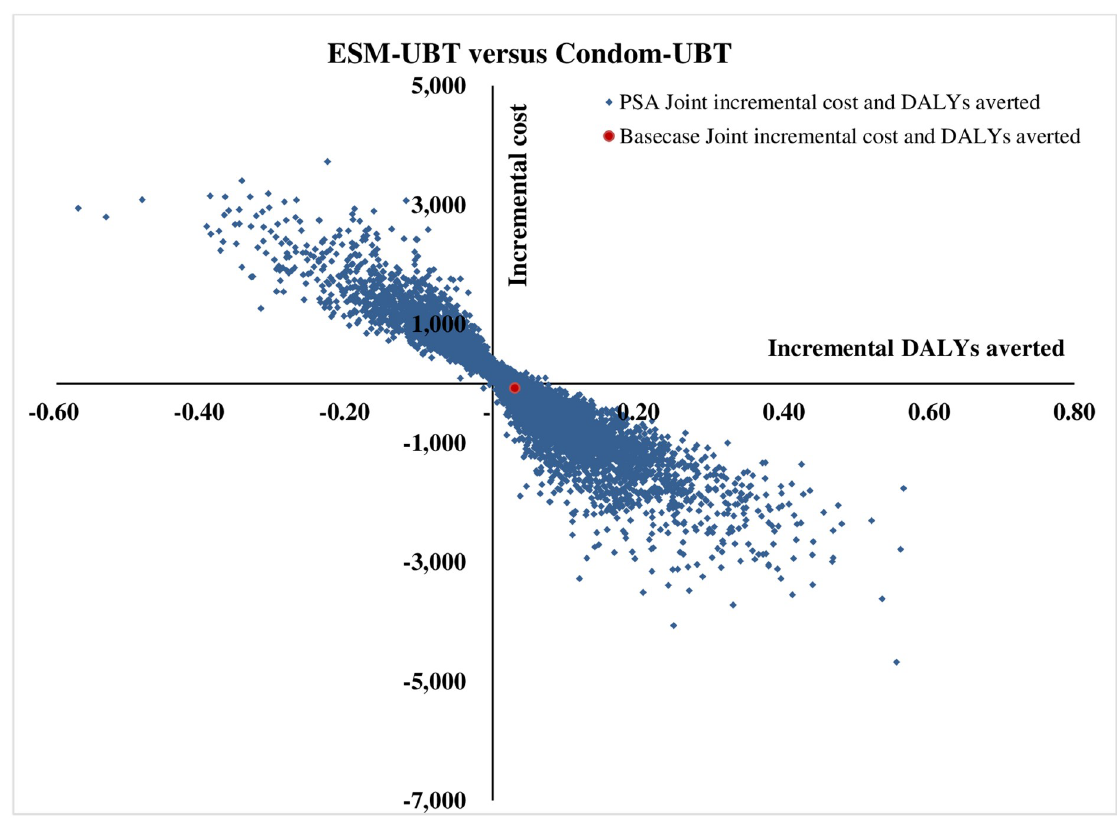
Fig 4. Probabilistic sensitivity analysis results with 10,000 Monte Carlo simulations for ESM-UBT versus condom-UBT comparison.